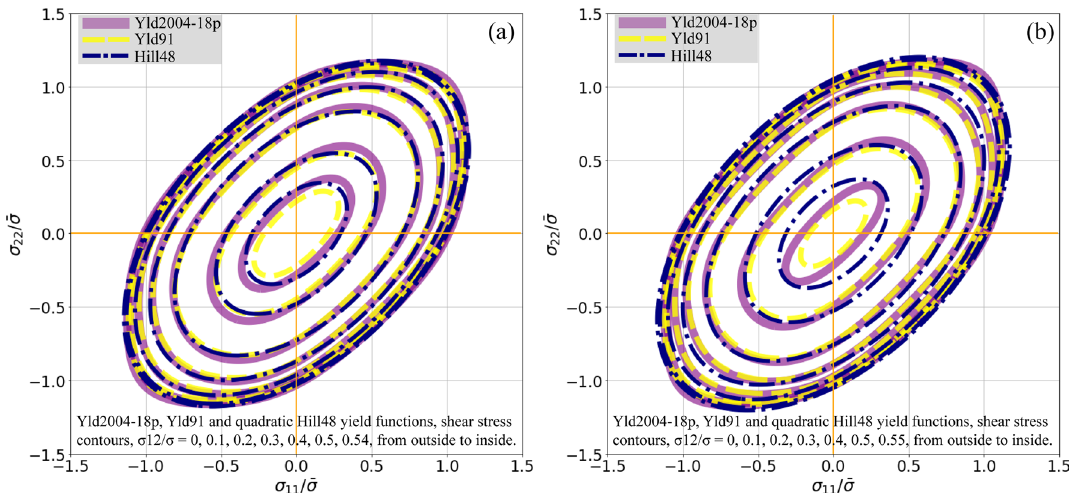
Figure 7. Tricomponent ( σ 11 − σ 22 − σ 12 ) yield loci with constant σ 12 / ¯ σ contours predicted by the calibrated yield functions for the DP980 sheet. The equivalent deformation stage with the specific plastic work of ( a ) 3 MPa and ( b ) 8 MPa. ¯ σ denotes the uniaxial tensile stress in RD obtained from the